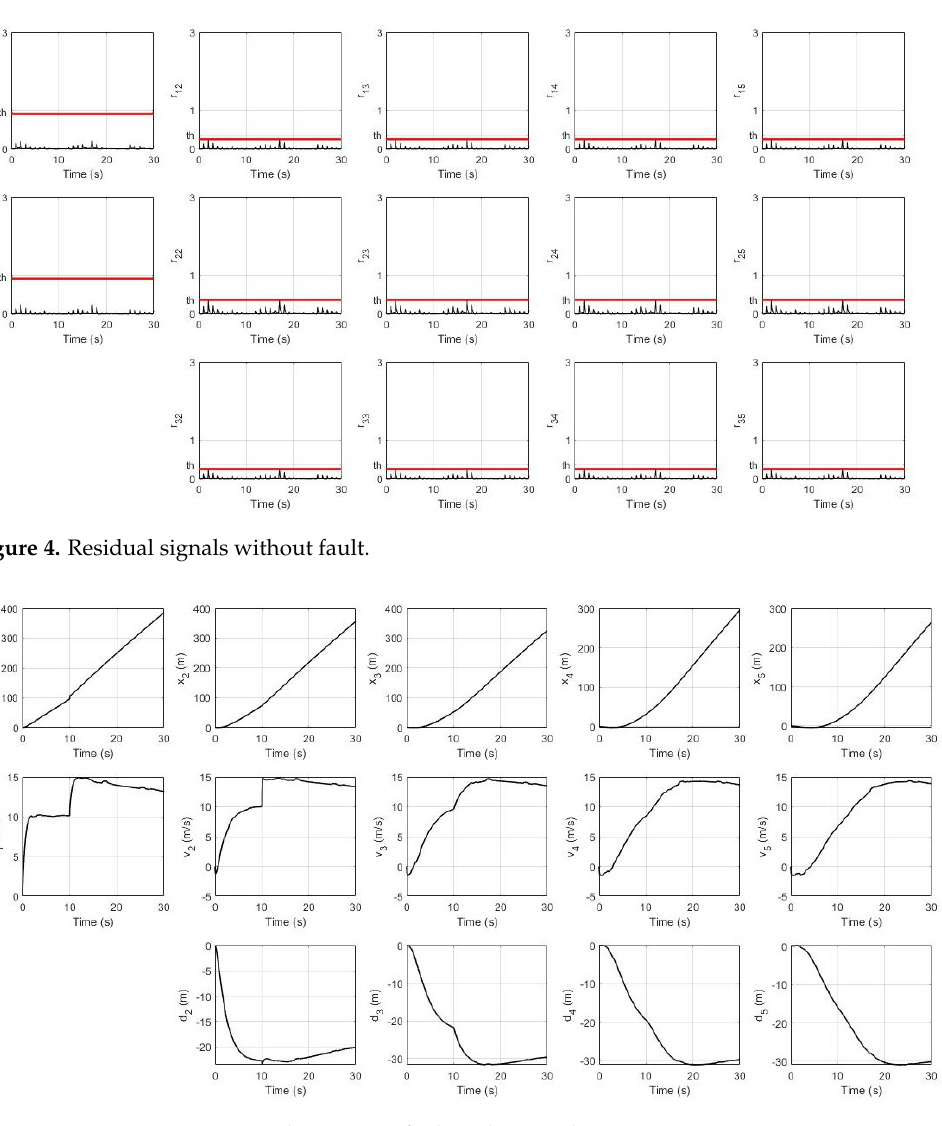
Figure 5. System’s response with sensor S1 fault in the 1st robot.